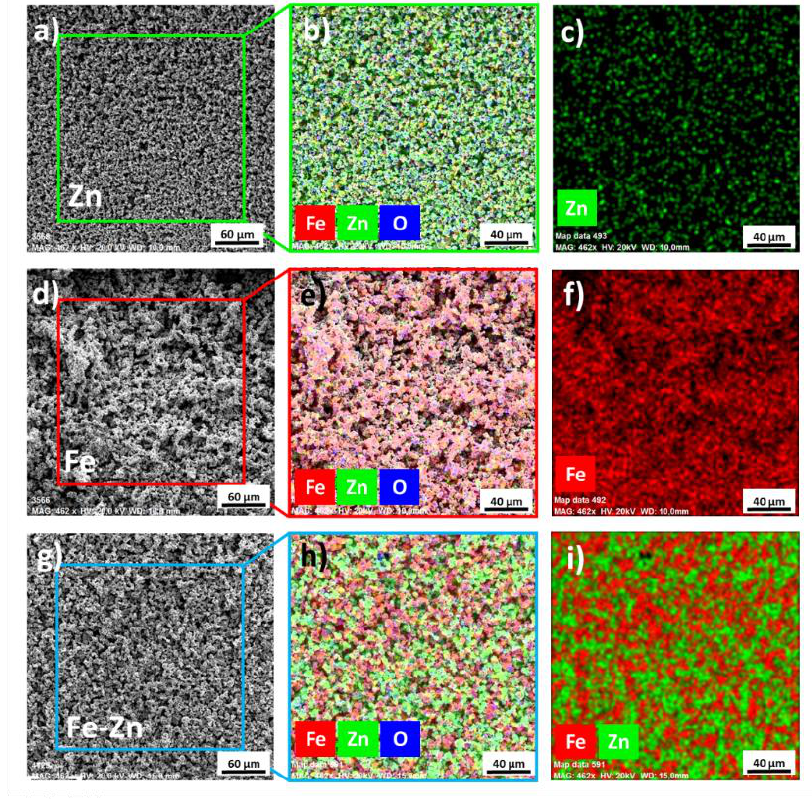
Figure 2. Chemical composition and particle distribution of Zn ( a – c ), Fe ( d – f ) and Fe-Zn ( g – i ) powders obtained from EDX analysis.